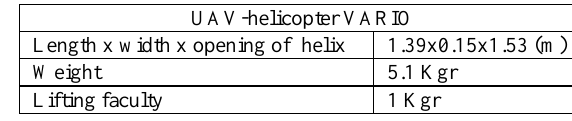
Table 6. UAV technical characteristics.